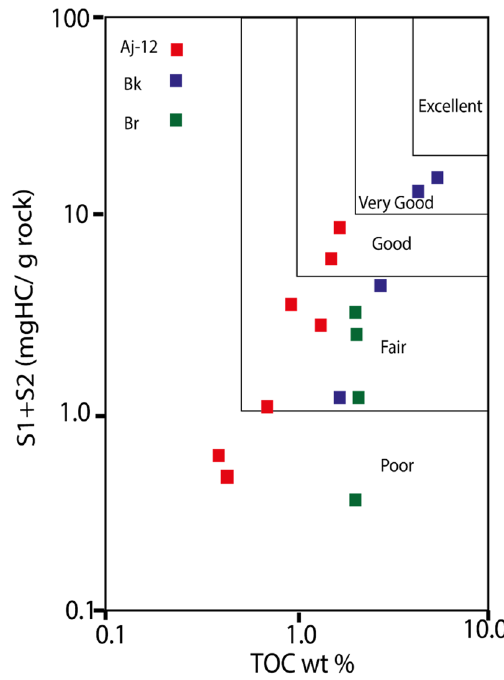
Fig. 15 TOC% vs. Generation Potential GP (S1 + S2) for the Chia Gara Formation. The Generation Potential of the studied samples indicates poor to very good potentiality